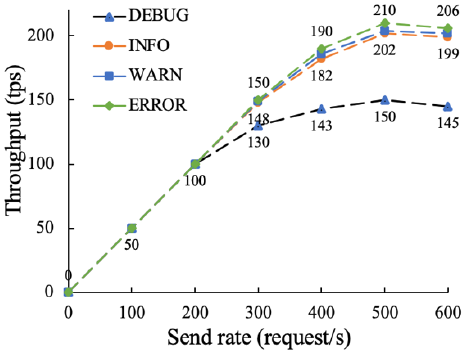
Table 3. Experimental parameter settings.